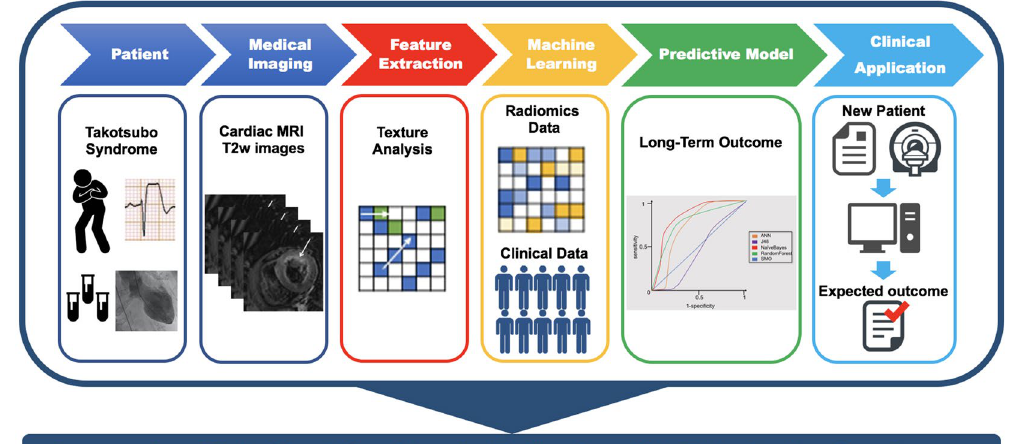
Figure 4. Improving risk stratification in patients with takotsubo syndrome. Cardiac magnetic resonance imaging-derived texture analysis features, identified through machine learning algorithms, have a prognostic value in patients with takotsubo syndrome. Thus, these features might serve as novel imaging biomarkers for risk stratification in takotsubo